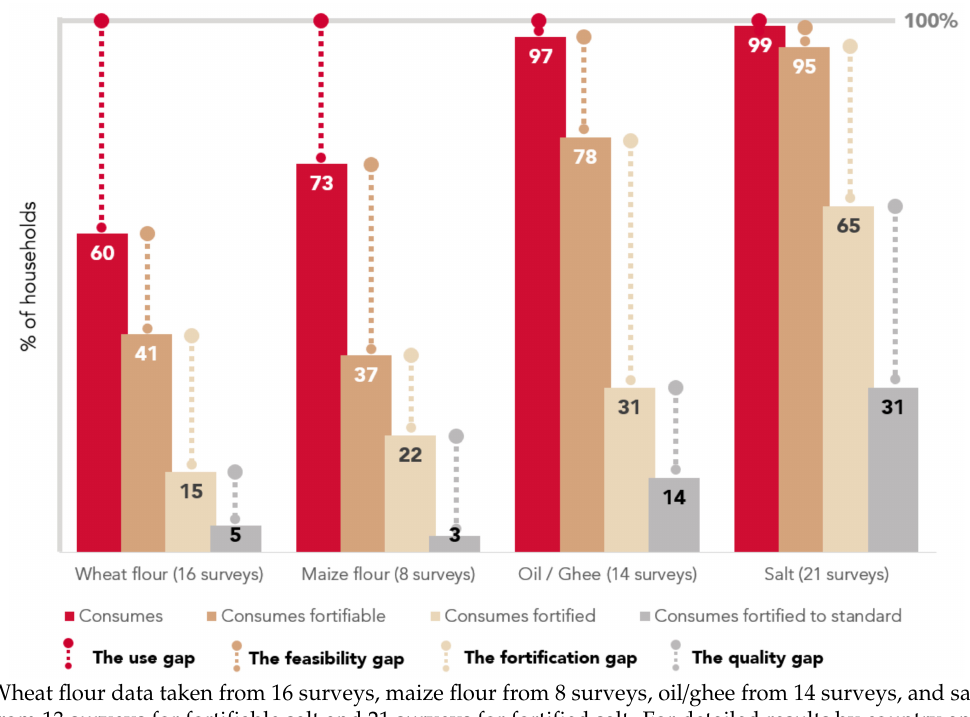
Figure 3. Aggregated data on fortification coverage and corresponding bottlenecks / gaps across multiple